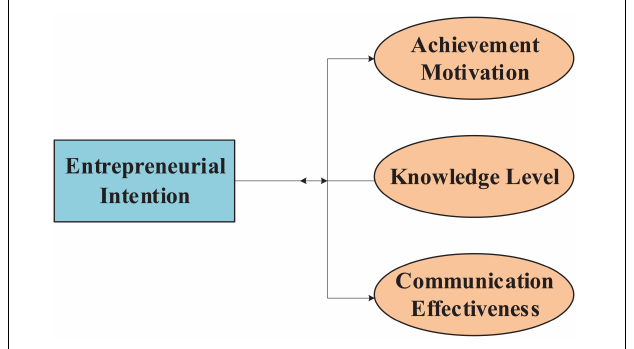
FIGURE 1 | The relationship between EI and AM, KL, CE.